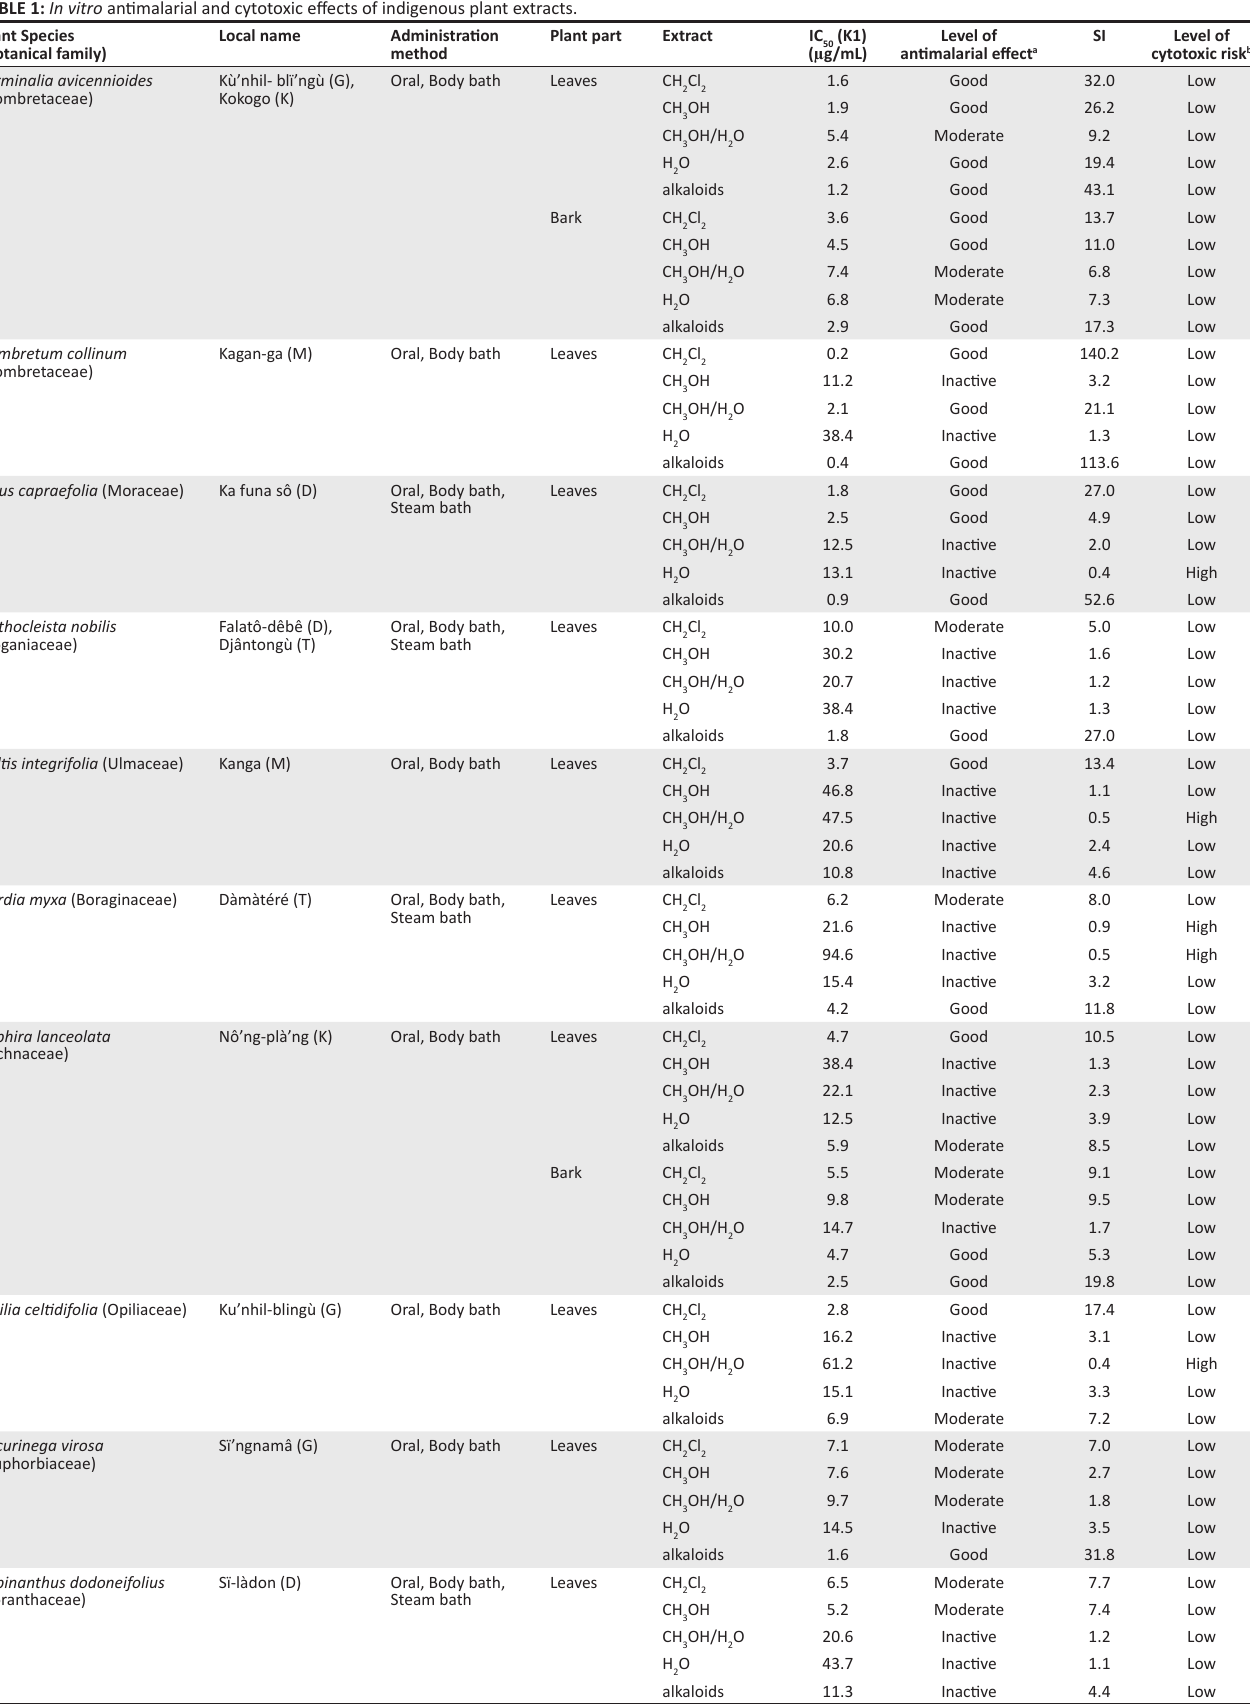
TABLE 1: In vitro antimalarial and cytotoxic effects of indigenous plant extracts. Plant Species (Botanical